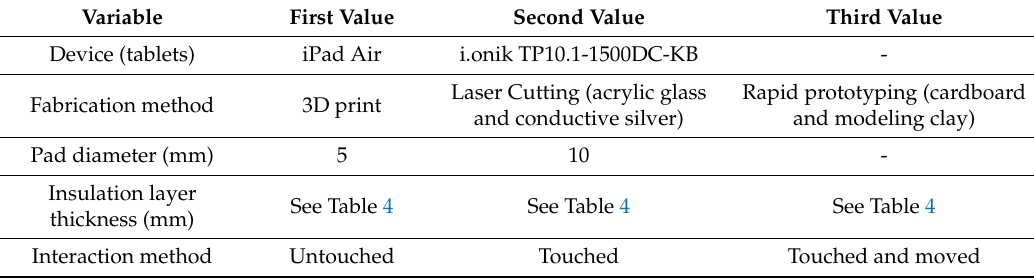
Table 3. Compilation of study variables and their values.